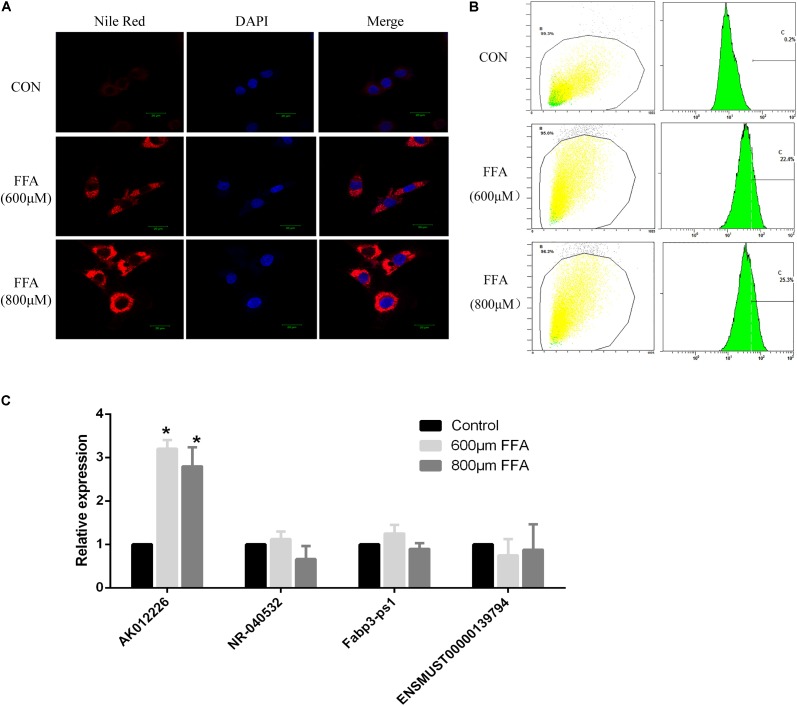
Expression of four differentially expressed lncRNAs in NCTC1469 cells treated with free fatty acids (FFAs). NCTC1469 cells were treated with FFAs at a concentration of 600 or 800 μM or dimethyl sulfoxide (DMSO) as control for 24 h. Obvious lipid accumulation was observed in FFA-treated cells compared to that in the control cells as detected by Nile red staining (A) and flow cytometry analysis (B). (C) Quantitative real-time PCR of four up-regulated genes (AK012226, NR-040532, Fabp3-ps1, and ENSMUST00000139794) were performed to examine their expression levels. AK012226 expression was significantly increased in the NCTC1469 cells treated with FFAs. The results are the means of three independent experiments. The values in bar graphs are means ± SD. ∗p < 0.05.